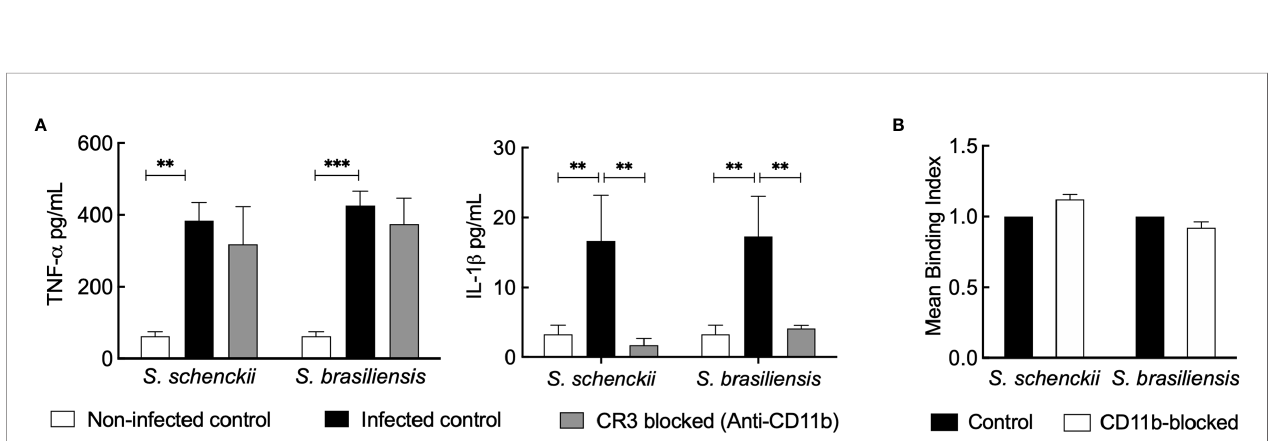
FIGURE 5 | (A) Cytokine released by human monocyte-derived macrophages (hMDMs) blocked for complement receptor-3 (CR3) and challenged with Sporothrix species. Sporothrix yeasts were made to interact with hMDMs blocked for CR3 (with monoclonal anti-CD11b antibodies) or unblocked (infected control) in a culture medium supplemented with whole human serum (wHS) for 18 h at 37°C and 5% CO 2 . Non-infected controls were hMDMs blocked with irrelevant antibodies and treated with culture medium supplemented with wHS. The culture supernatants were collected and analyzed for tumor necrosis factor (TNF)- a and interleukin (IL)-1 b . Results indicate the mean ± SEM of at least two independent experiments in duplicate or triplicate (n = 4 or 6). ANOVA with Tukey ’ s multiple comparison posttest was performed for the statistical analysis (***p < 0.001, **p < 0.001). (B) Uptake of Sporothrix yeasts by hMDMs after CR3 blockage. hMDMs were incubated with monoclonal anti-CD11b antibodies for 1 h and challenged with FITC-labeled yeasts of Sporothrix schenckii or Sporothrix brasiliensis. After 4 h of interaction in the presence of medium containing wHS, hMDMs were analyzed by FACS to determine the change in mean binding index (MBI) compared to control (=CD11b unblocked hMDMs interacted with FITC-labeled Sporothrix yeasts). Results are the mean ± SD of an experiment performed in duplicate.